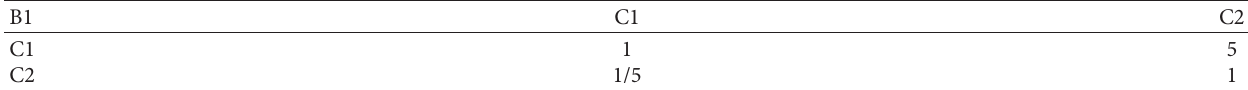
Table 12: The judgment matrix of subcriteria with respect to business level